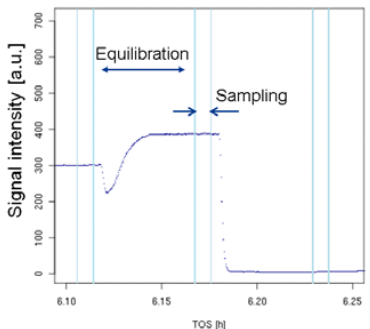
Figure 3. Time dependency of the analytical signal for selected positions in steady-state